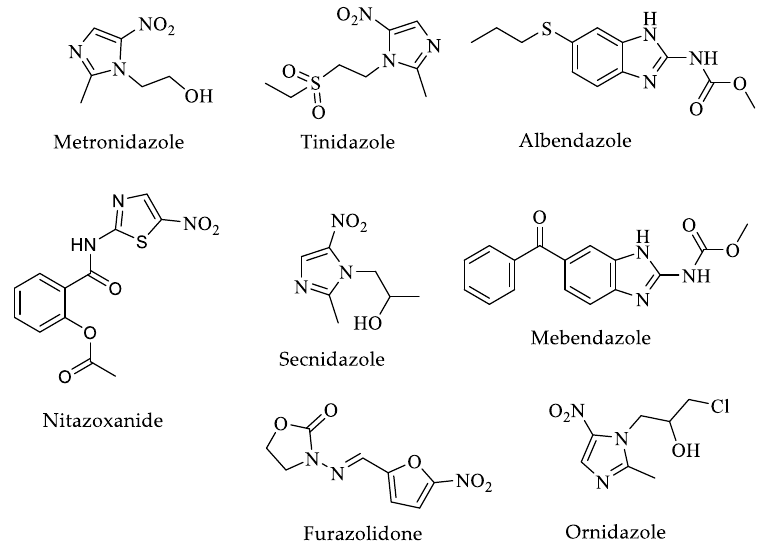
Figure 16. Main drugs used for the pharmacological treatment of giardiasis.